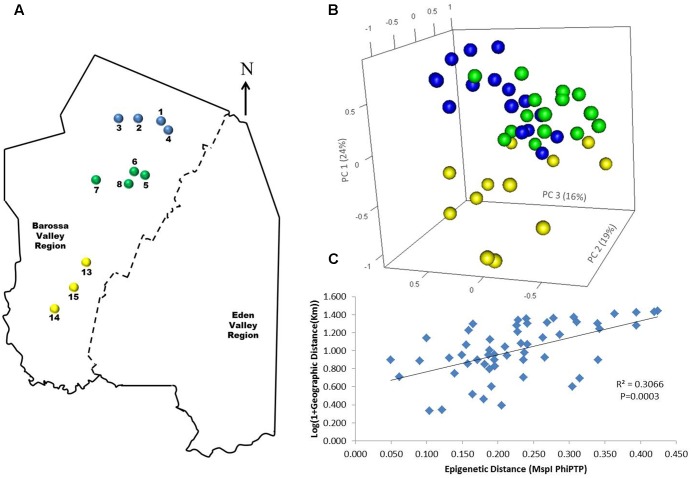
Analysis of the correlation between molecular differentiation and geographic distance (Km) of vineyards planted along the Barossa Valley North–South axis. (A) Location of the Barossa Valley vineyards from the three sub-regions distributed along the Barossa Valley North–South axis; Northern Grounds (blue), Central Grounds (green), and Southern Grounds (yellow). Arrow indicates the direction of geographic North. (B) PCoA representing genetic and epigenetic differences between leaf samples collected from four plants/vineyard. Percentage of the variability capture by each principal coordinate (PC) is shown in parenthesis. (C) Correlation between pairwise genetic/epigenetic distance (MspI PhiPT) and geographical distance [Log(1 + GeoD) km] between vineyards. Shown equations are the correlation’s R2 and the Mantel test significance (P-value was estimated over 9,999 random permutations tests). PCoA and PhiPT for Mantel test were based on presence/absence of 215 loci obtained from MSAP profiles generated using MspI.